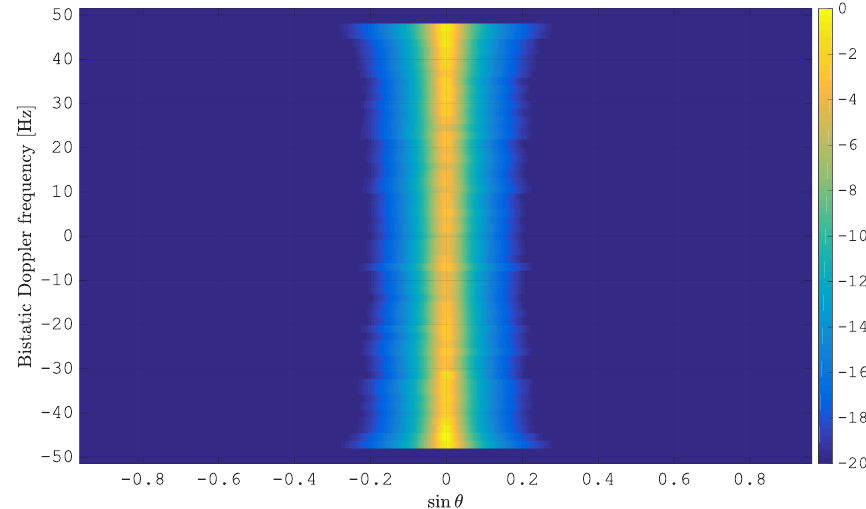
Figure 5. Minimum variance power spectrum estimated from simulated clutter after flex-DPCA and calibration using